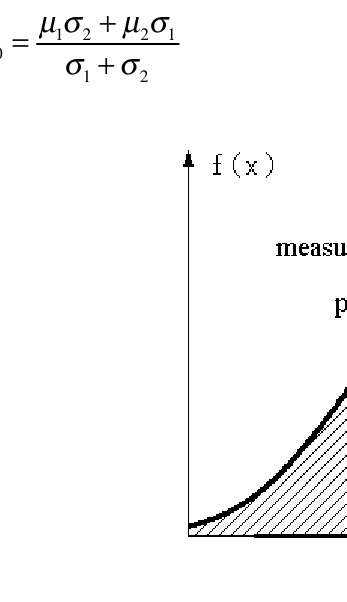
Figure 4. An example of x